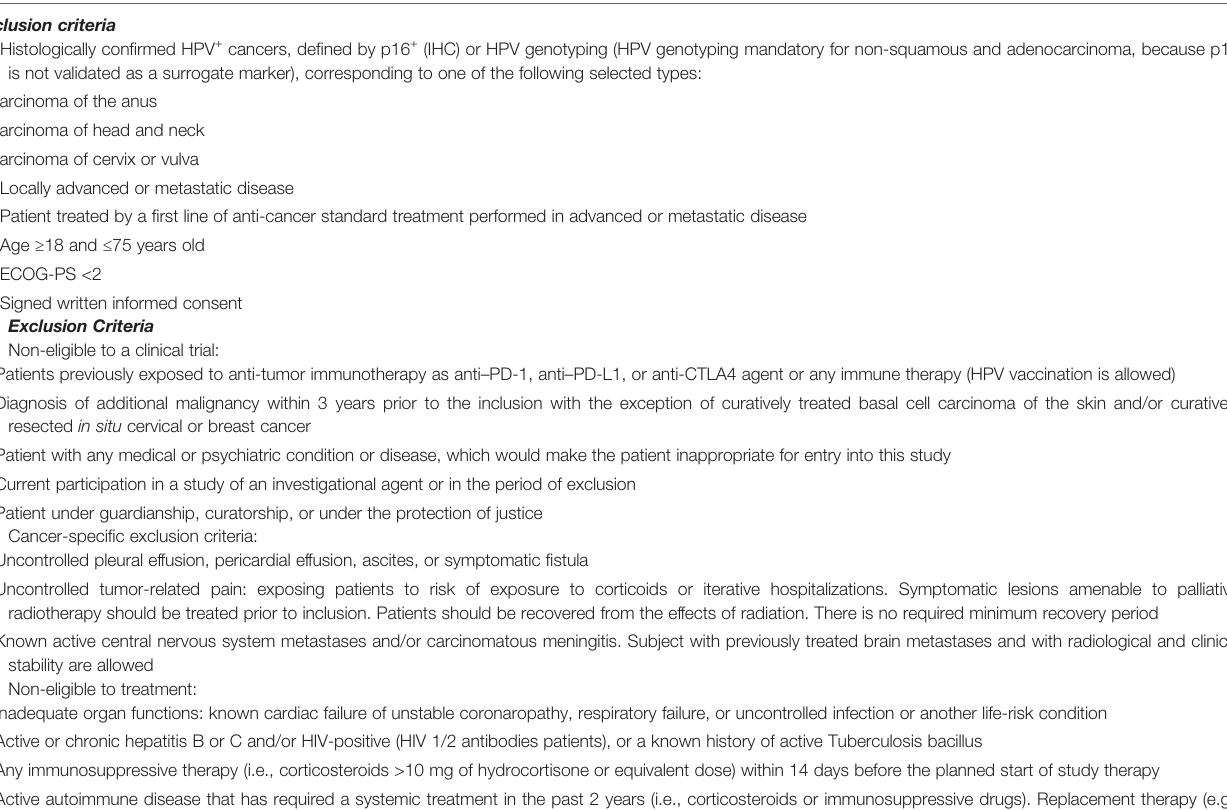
TABLE 2 | Main inclusion and exclusion